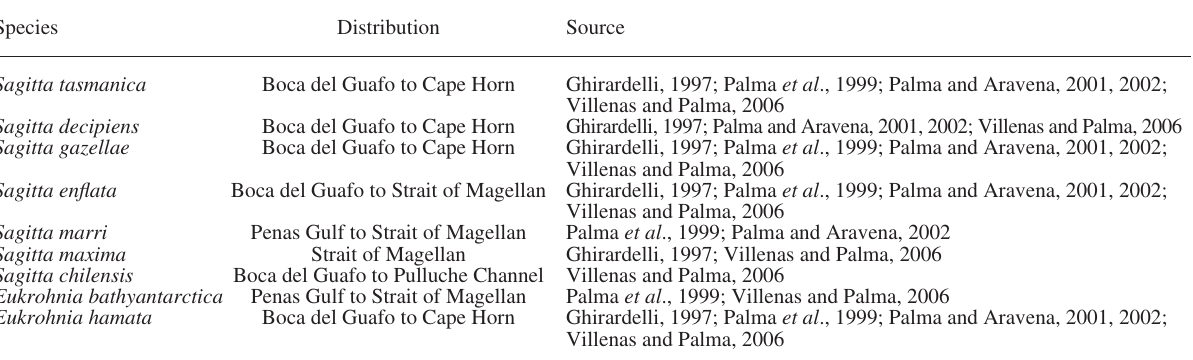
Table 5. – Geographic distribution of the chaetognath species recorded off southern Chile. Boca del Guafo (43º40’S), Pulluche Channel (45º47’S), Penas Gulf (47º10’S), Strait of Magellan (52º45’S), and Cape Horn (56º01’S). Species